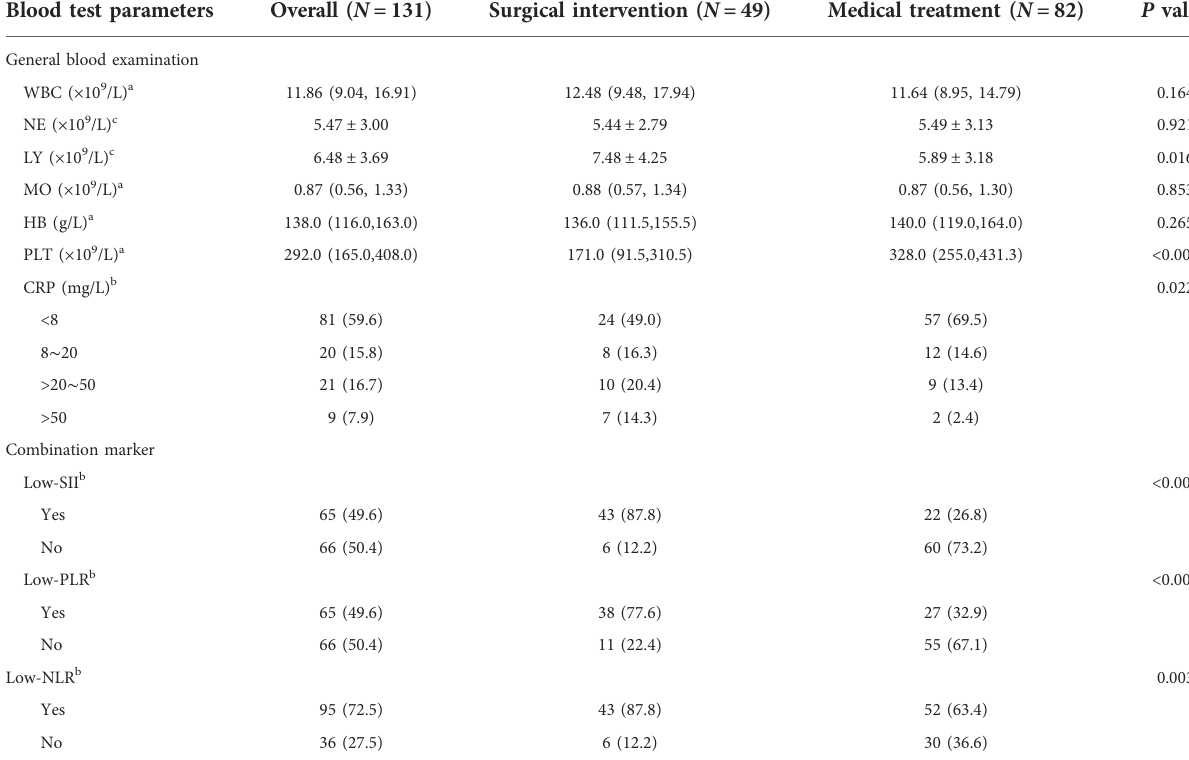
TABLE 3 Laboratory data comparison between surgical intervention and medical treatment. Blood test parameters